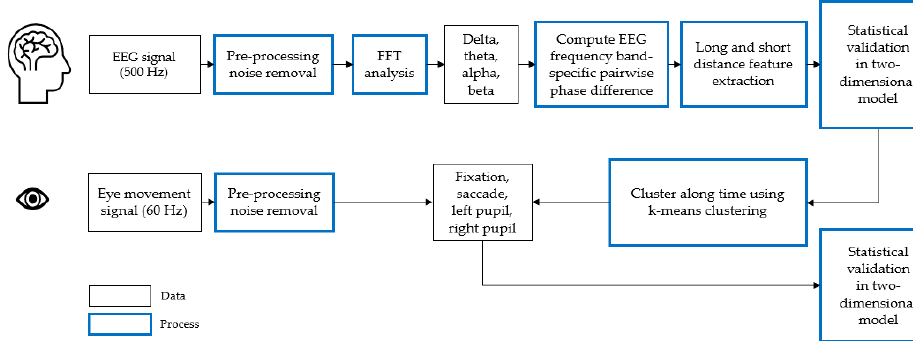
Figure 3. The process of brain connectivity analysis.